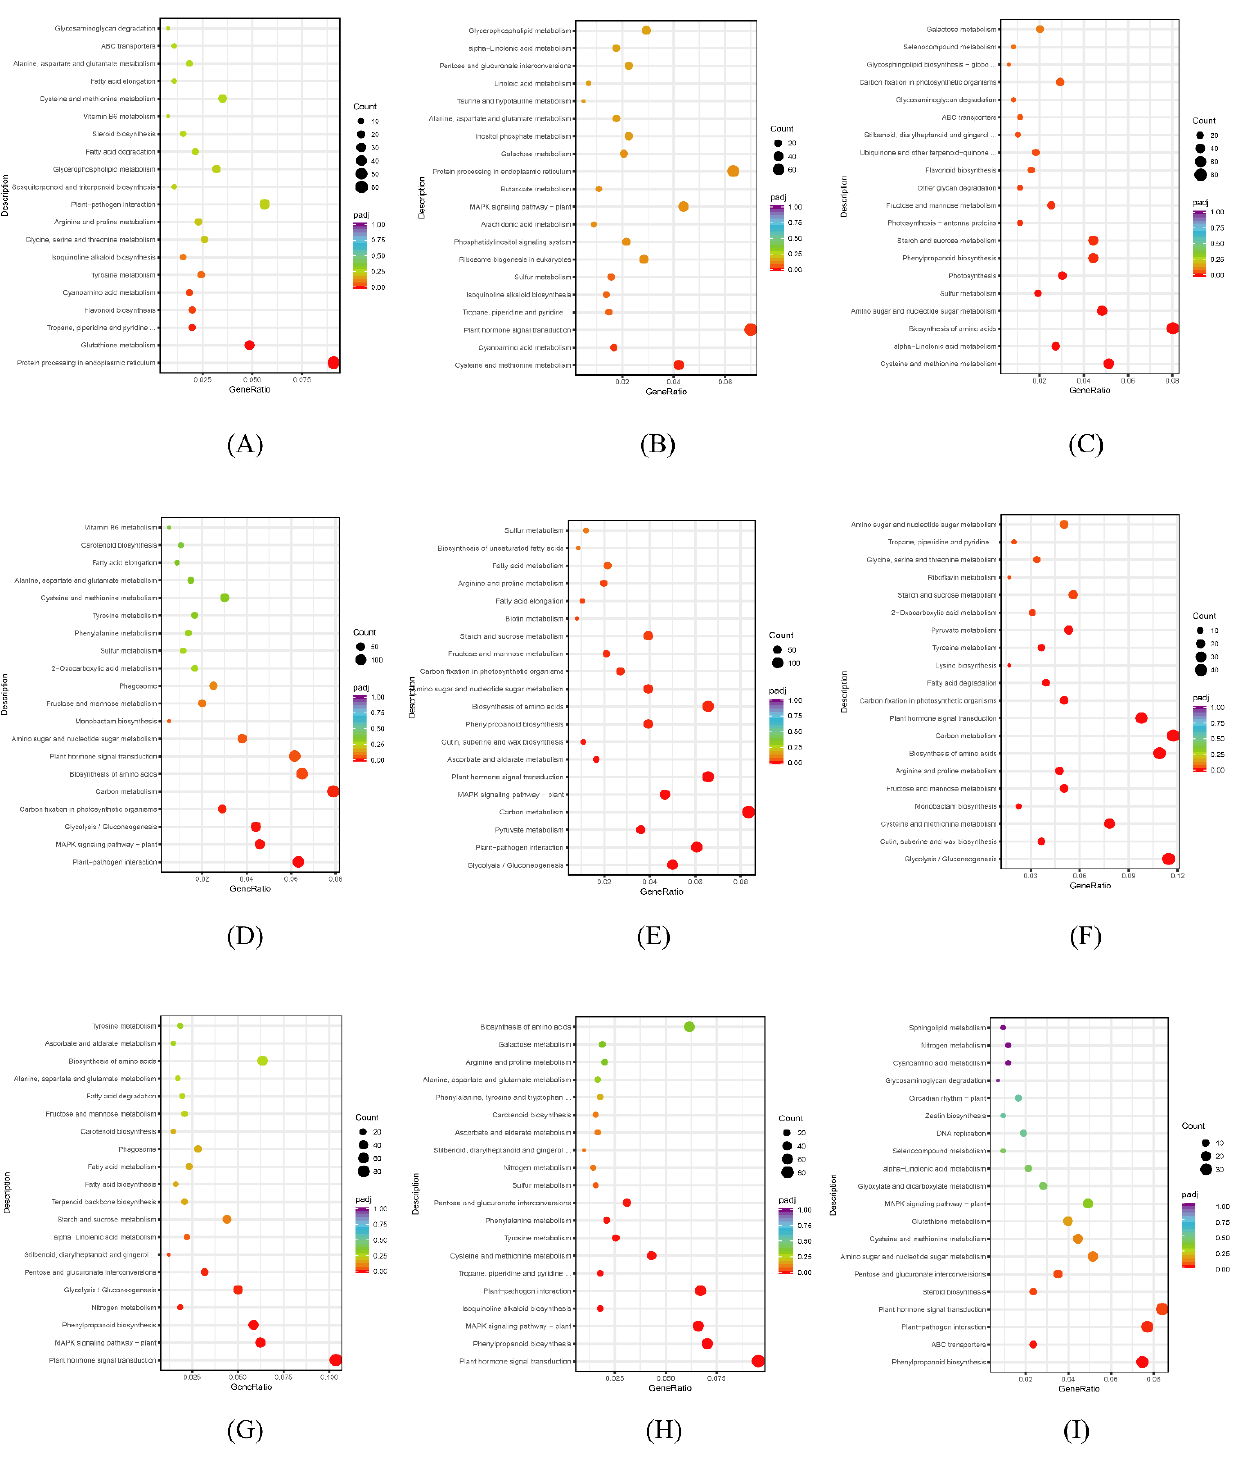
Figure 8. KEGG pathway enrichment analysis of differentially expressed genes in each comparison group of leaf, stem and root. ( A ) L200 vs. L0; ( B ) L400 vs. L0; ( C ) L400 vs. L200; ( D ) S200 vs. S0; ( E ) S400 vs. S0; ( F ) S400 vs. S200; ( G ) R200 vs. R0; ( H ) R400 vs. R0; ( I ) R400 vs. R200.